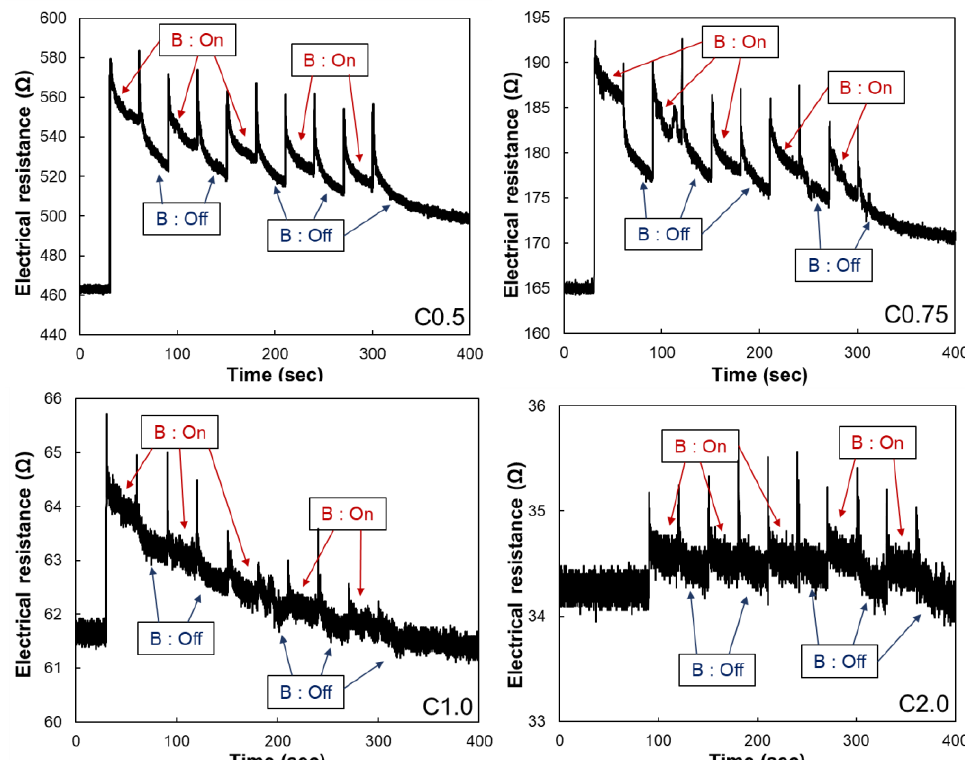
Figure 4. Magneto-resistances of the samples with various CNTs contents.